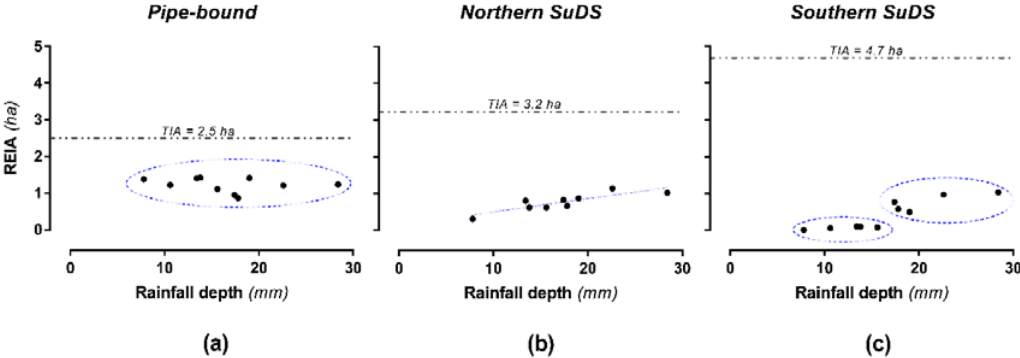
Figure 5. Calculated REIA in case of the observed rainfalls for all three catchments in Augustenborg compared to the TIA (based on field surveys and GIS maps as given in Nordlöf [21]): ( a ) Pipe-bound; ( b ) Northern SuDS; ( c ) Southern SuDS.